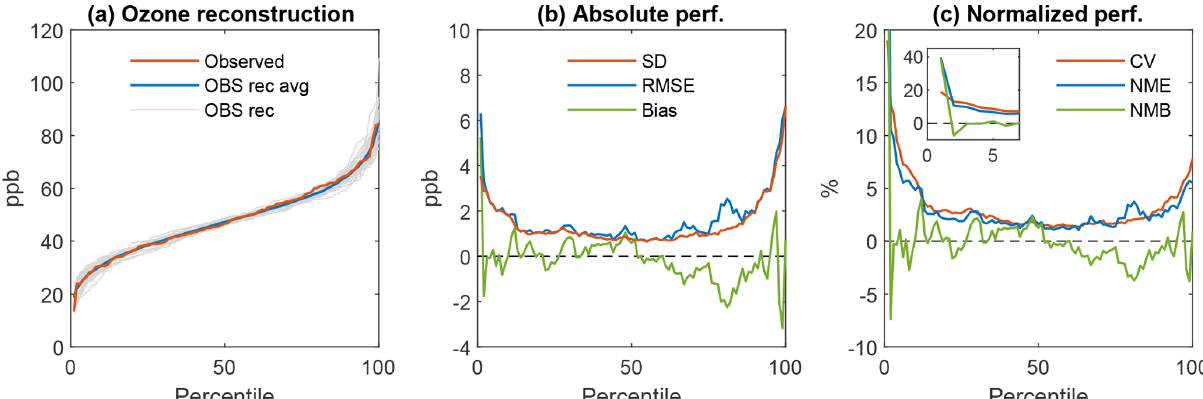
Figure 3. (a) Comparison between the observed cumulative distribution function (CDF) for 2010 shown in red with 30 + pseudo- observation CDFs generated from historical DM8HR ozone time series shown in gray at a suburban site at Altoona, PA (AQS station identifier 420130801). The blue line represents the average of the 30 + gray lines. (b) Display of various statistical performance (perf.) metrics (standard deviation – std, root mean square error – RMSE, and bias) derived by comparing the actual observed and pseudo ozone values in panel (a) . (c) Normalized statistical metrics of the normalized mean error (NME), normalized mean bias (NMB), and coefficient of variation (CV). Notice the large variability occurring at the lower and upper